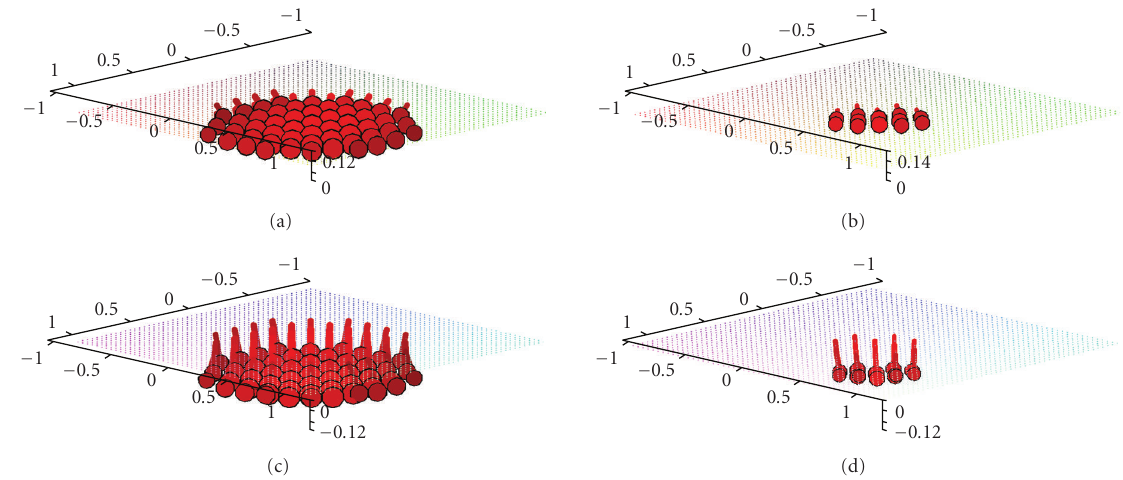
Figure 15: Top: reconstruction of the vector field f ( x ) = (1,1,1) (cid:9) with the described algorithm for γ = 0 . 007 in the planes (a) { x 3 = 0 . 75 } and (b) { x 3 = 0 . 95 } . Bottom: reconstruction of the vector field f ( x ) = (1,1, − 1) (cid:9) with the described algorithm for γ = 0 . 007 in the planes (c) { x 3 = 0 . 75 } and (d) { x 3 = 0 . 95 } .